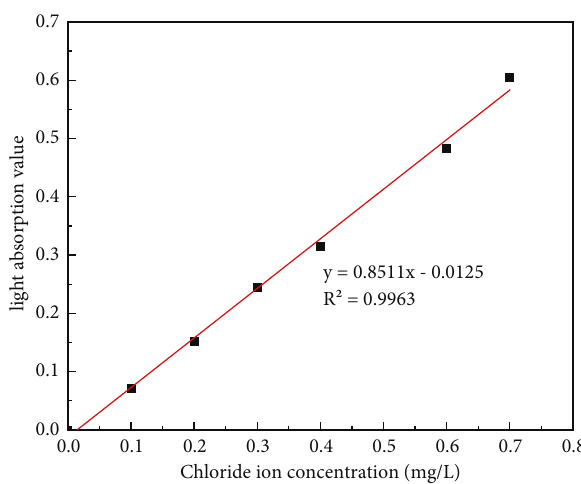
Figure 7: Parameters and standard curve of